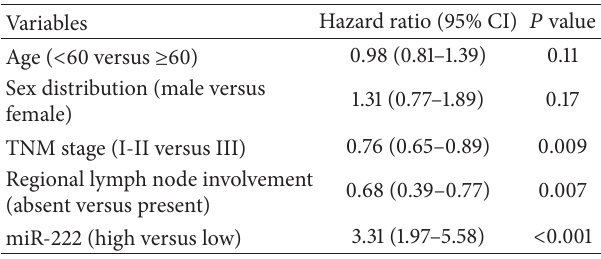
Table2:Multivariateanalysesforprognosticfactorsinpatientswith non-small cell lung